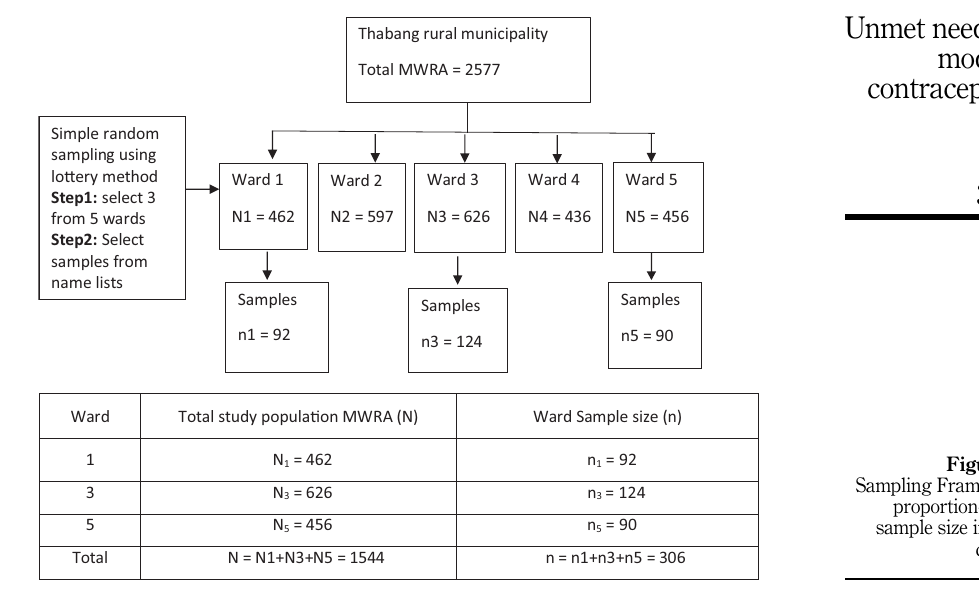
Figure 1. Sampling Frame with proportion-based sample size in each